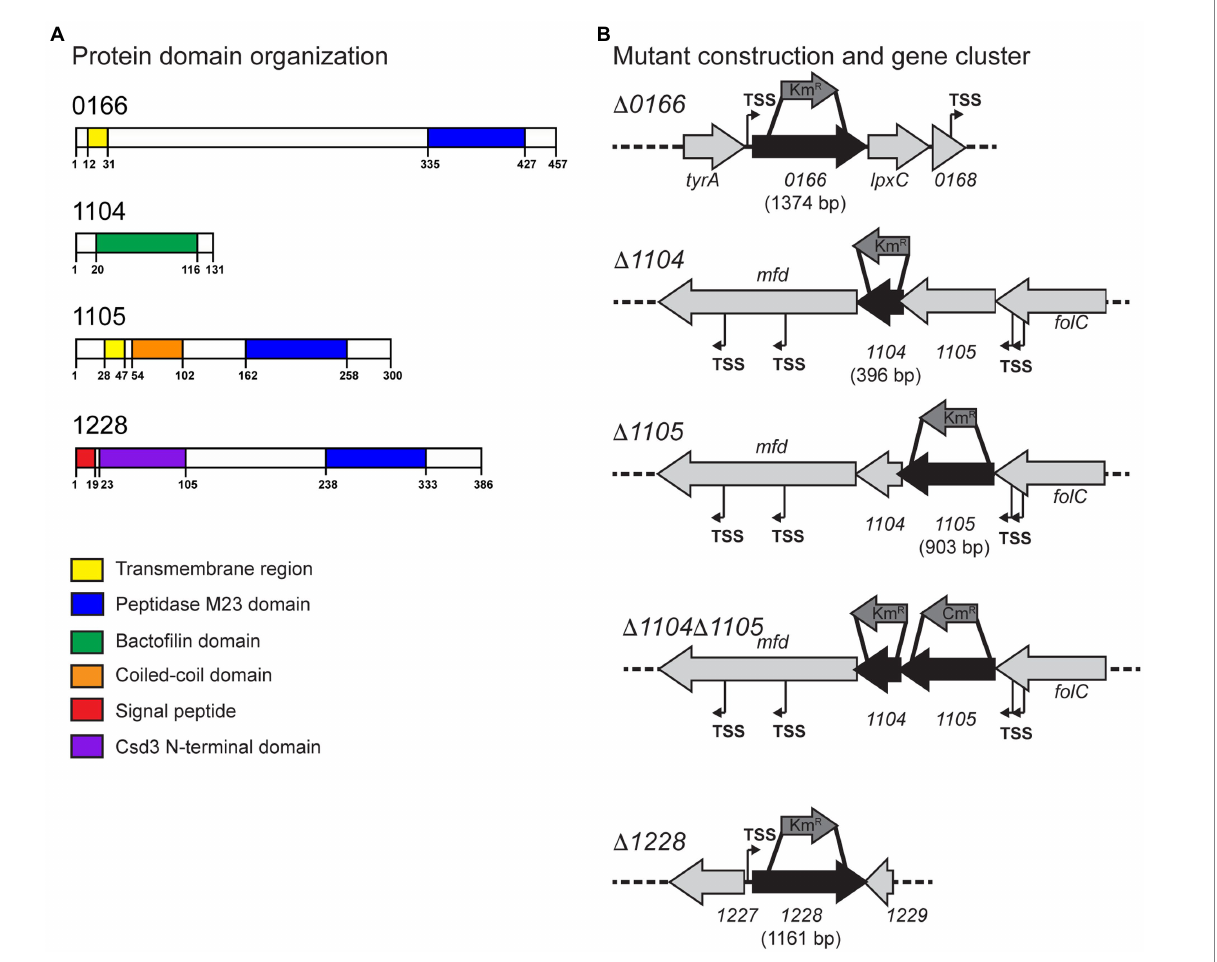
FIGURE 1 Protein domains of Campylobacter jejuni 0166, 1104, 1105, and 1228 and the corresponding gene loci. (A) The protein domains in the 0166 , 1104 , 1105 , and 1228 gene products predicted by jackhmmer. (B) The gene loci of 0166 , 1104 , 1105 , 1104 – 1105 , and 1228 and the approximate location of the internal fragments deleted and replaced with a non-polar Km R cassette or a Cm R cassette for mutant construction. Putative promoters (transcription start sites, TSS) predicted by RNA-seq are indicated (Dugar et al.,